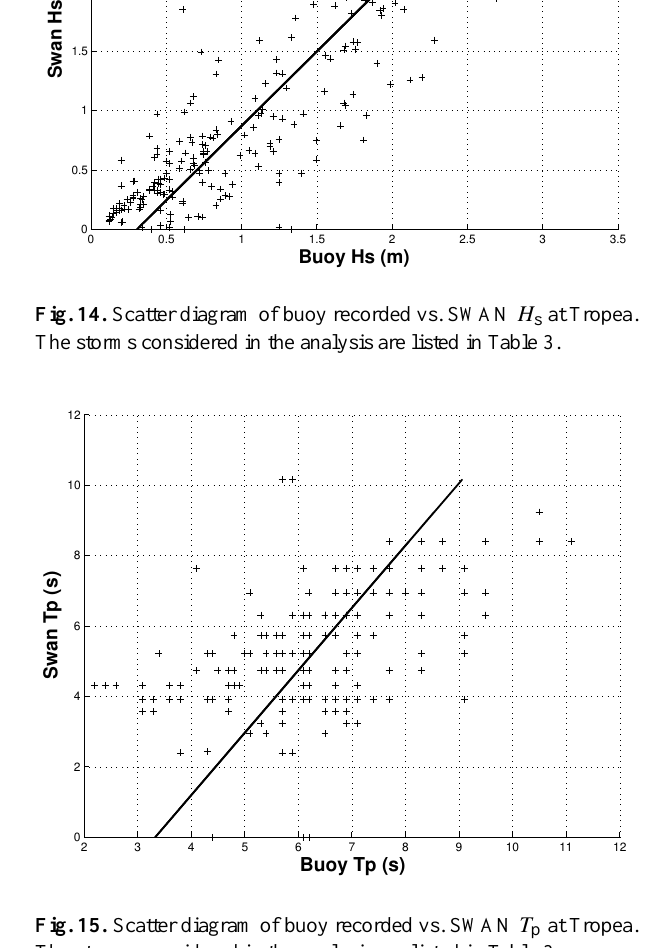
Fig. 15. Scatter diagram of recorded vs. SWAN T p at Tropea. The The storms considered in the analysis are listed in Table